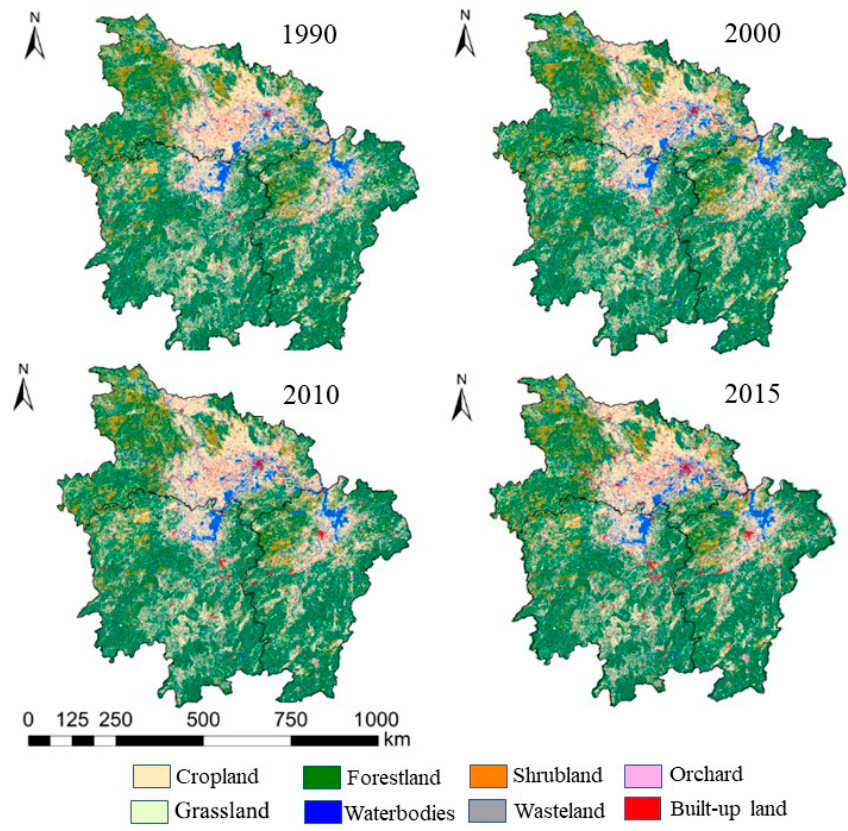
Figure 3. Spatiotemporal change of land use types in the MRYRR from 1990 to 2015.